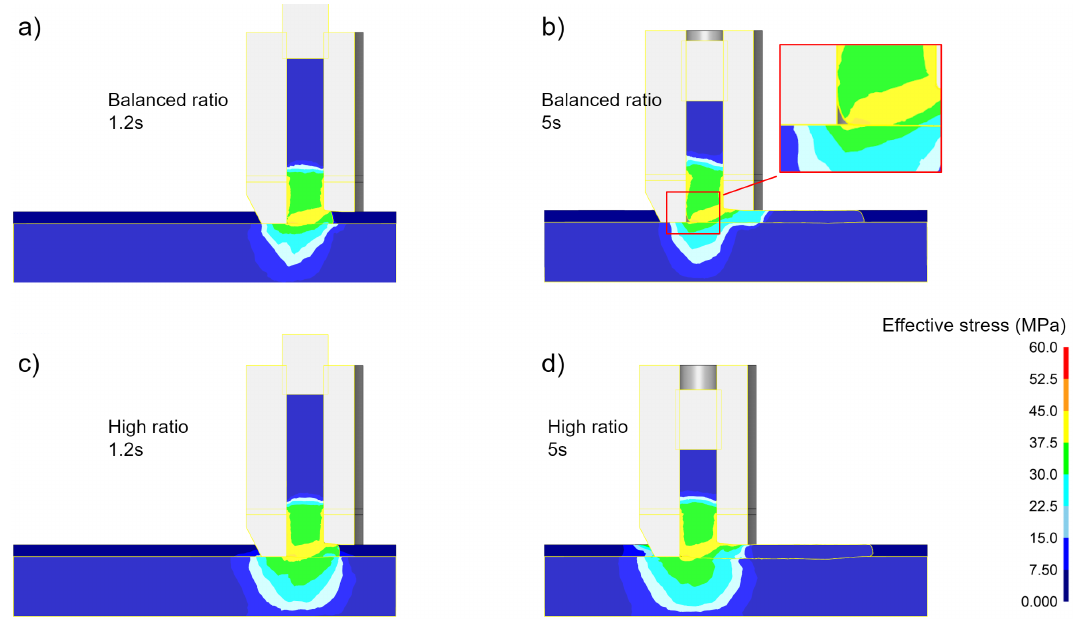
Figure 13. Effective stress during deposition at 500 ◦ C. ( a ) balanced ratio; after 1.2 s the die cavity is filled and the feeding has started; ( b ) balanced ratio; after 5 s a pocket is formed in the front section of the die; ( c ) high ratio; after 1.2 s, the die cavity is filled; ( d ) high ratio; after 5 s, the die cavity is still full and the effective stress has increased.